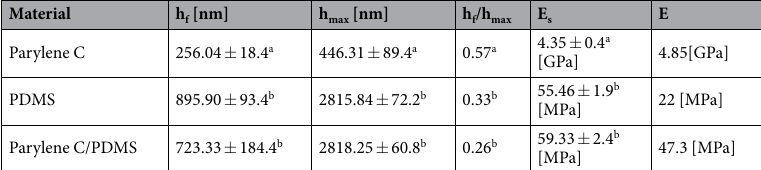
Table 1. Mechanical properties of the constructs. a Values for 0.9 mN. b Values for 1 mN.